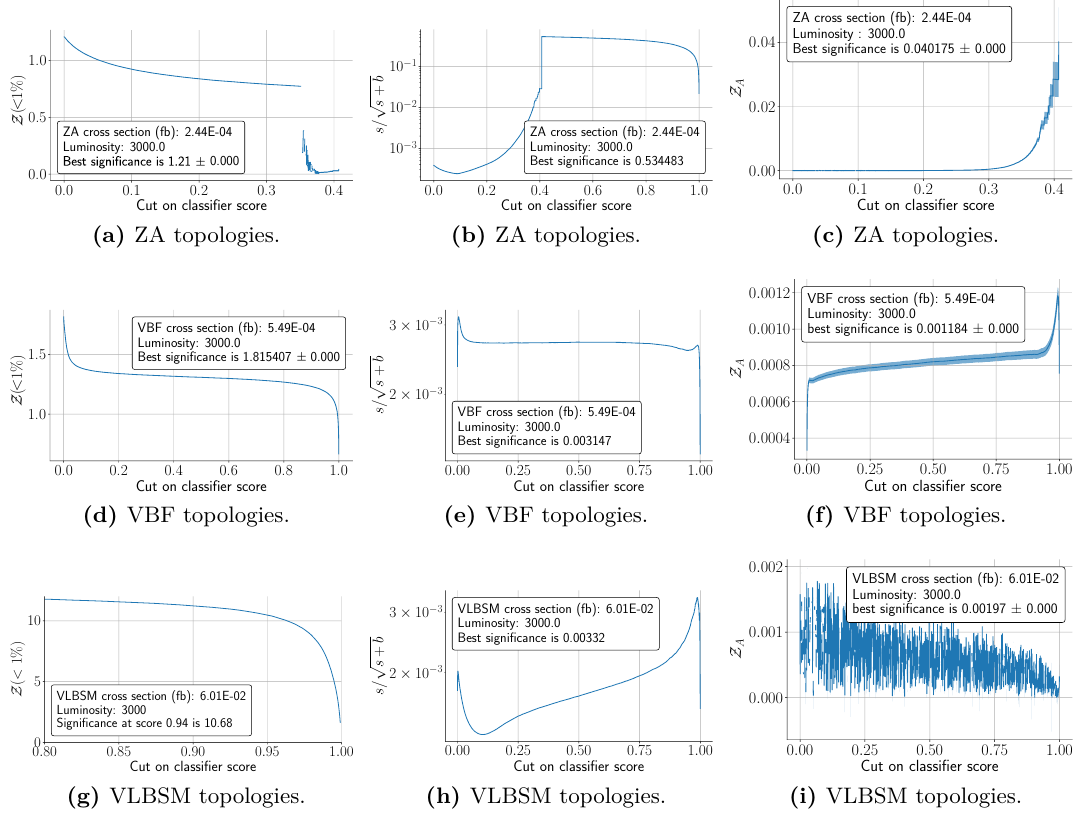
(g) VLBSM topologies. Figure 10. Significance as a function of the NN scores for each signal topology for a light VLL with mass m = 677 GeV and an integrated luminosity of L = 3000 fb − 1 . For plots (a), (d) and (g) we e 4 showcase the adapted Asimov significance where backgrounds are known with an error of up to 1 % , √ for (b), (e) and (h) the naive significance s/ s + b and for (c), (f) and (i) the Asimov significance. Plots are computed following an implementation of an evolutive algorithm that maximizes the accuracy